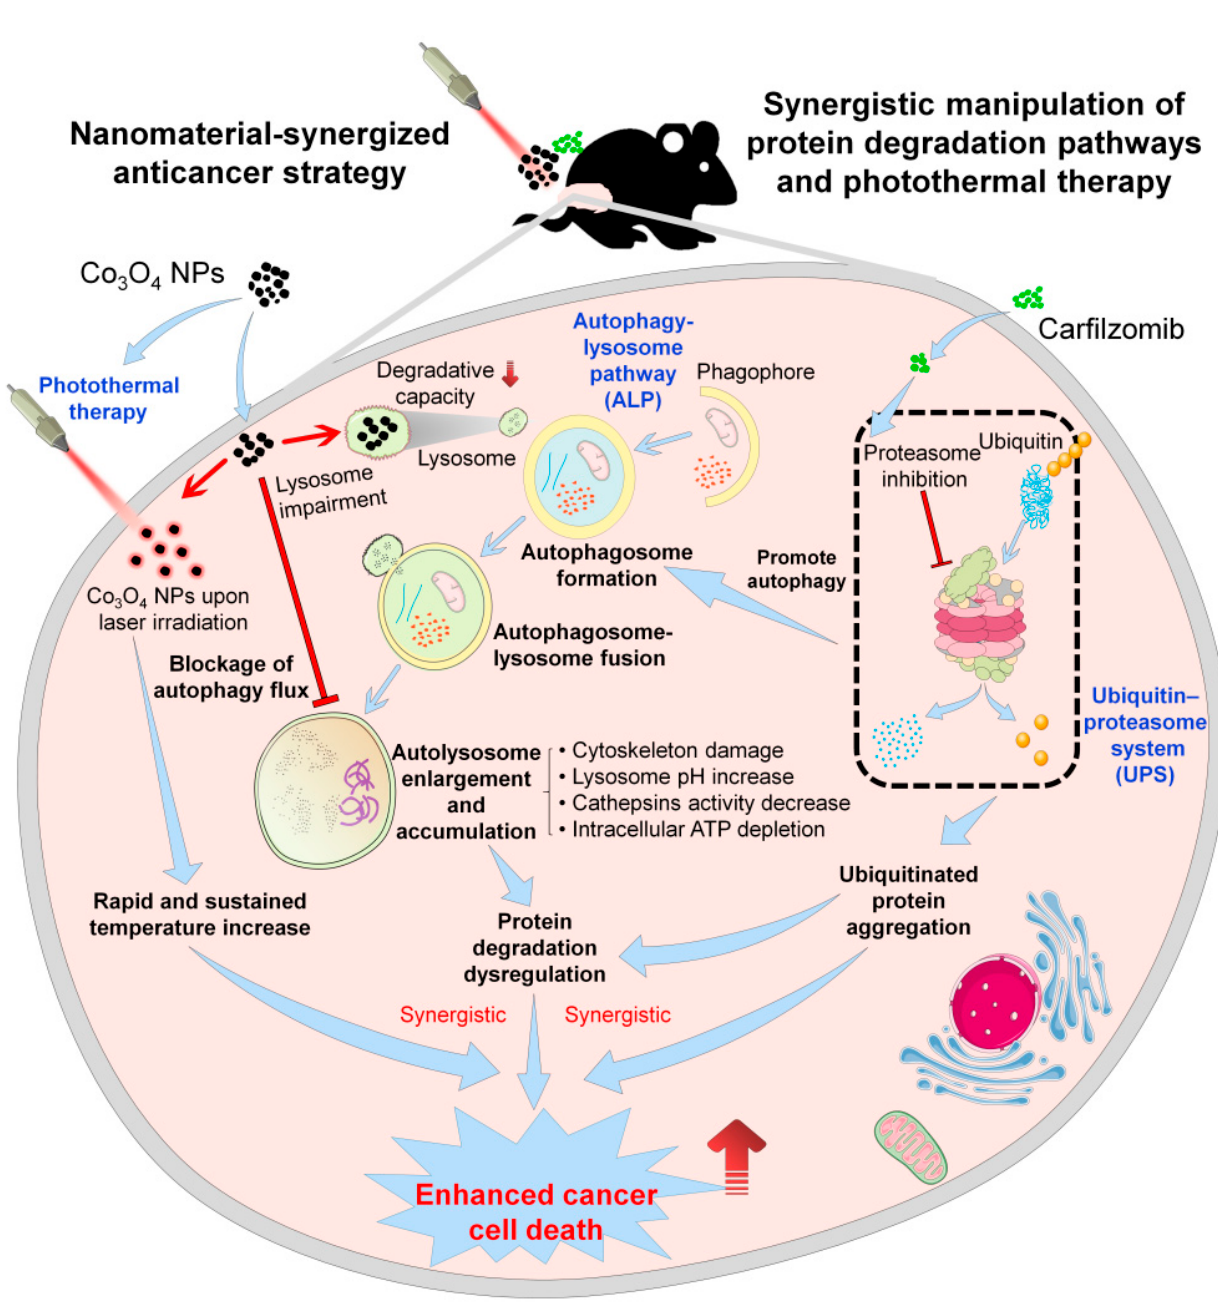
Figure 5. Co 3 O 4 NPs synergized strategy manipulating autophagy, proteasome and photothermal therapy for enhanced anticancer therapeutics. Reproduced with permission from [20]. Copyright Elsevier, 2021.